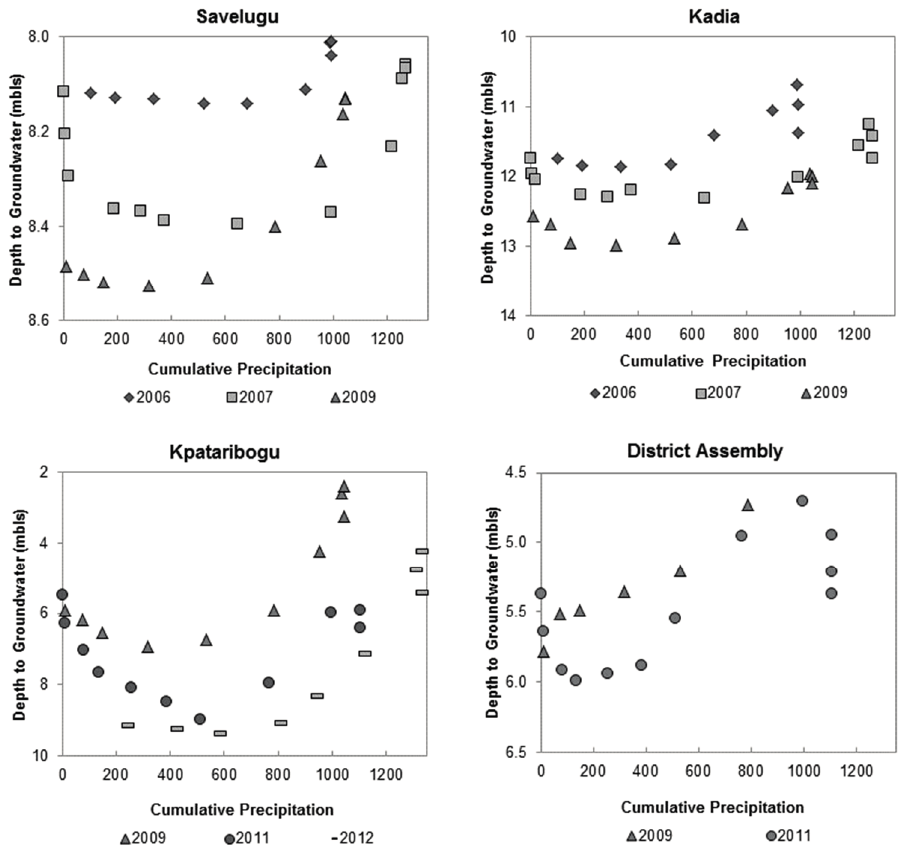
Figure 4. Cumulative monthly precipitation and monthly groundwater level. Cumulative monthly precipitation is summed for each month beginning in January and added to the sum of the previous month until December is reached. The monthly groundwater level is measured as meters below land surface (mbls) at the study